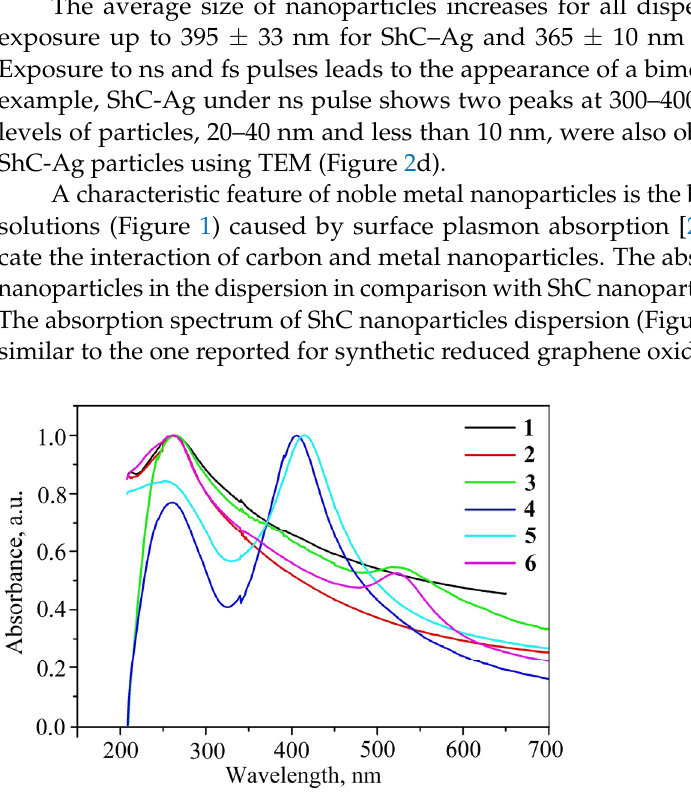
Figure 3. UV-visible adsorption spectra of aqueous dispersions of ShC initial (1), irradiated by nanosec laser (2); its hybrids irradiated by nanosec laser: ShC-Au-ns (3); ShC-Ag-ns (4) and irradiated by femtosec laser: ShC + Ag-fs (5); ShC-Au (6). The main peak observed in the UV spectra of water ShC dispersions is a plasmon peak at 261 nm (Table 1), which indicates a high degree of conjugation and sp 2 -hybridization of graphene ShC fragments and the lower energy of corresponding π - π * transition capable of contributing to the position of the 260 nm peak graphene [24].